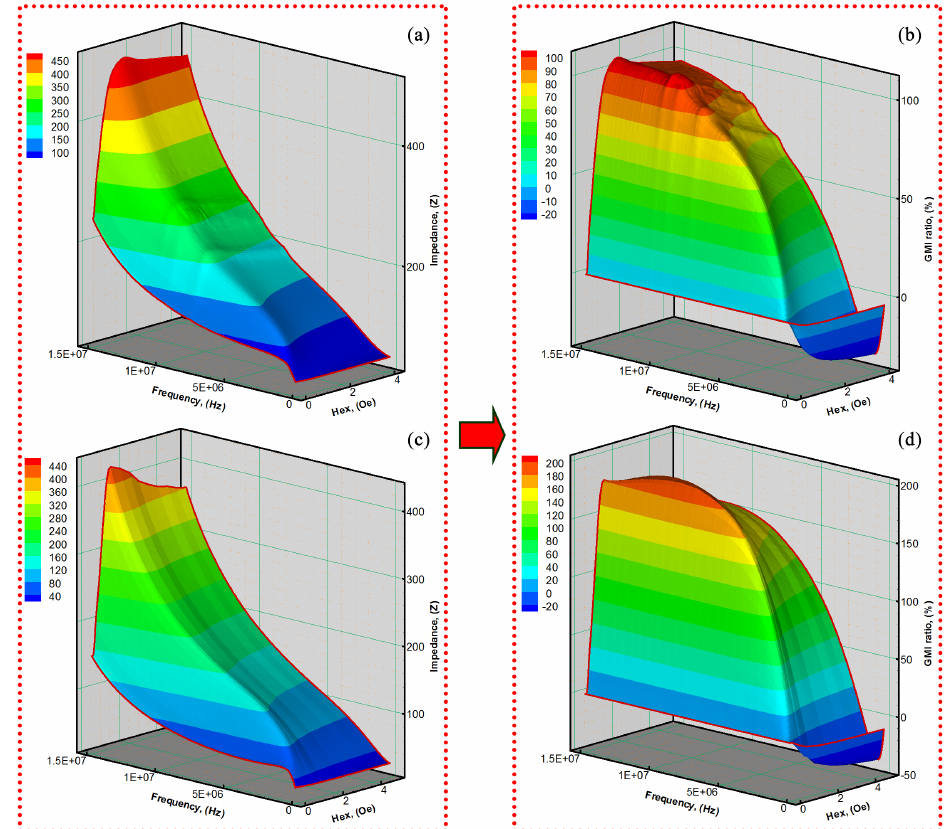
Figure 3. 3D images of impedance (a) and (c) and their corresponding GMI ratio Δ Z / Z field H (0~5.0 Oe) in range of frequency (100 kHz~15 MHz) for as-cast and SPCJA-ed (50Hz, 75mA, 480s) microwires, ex